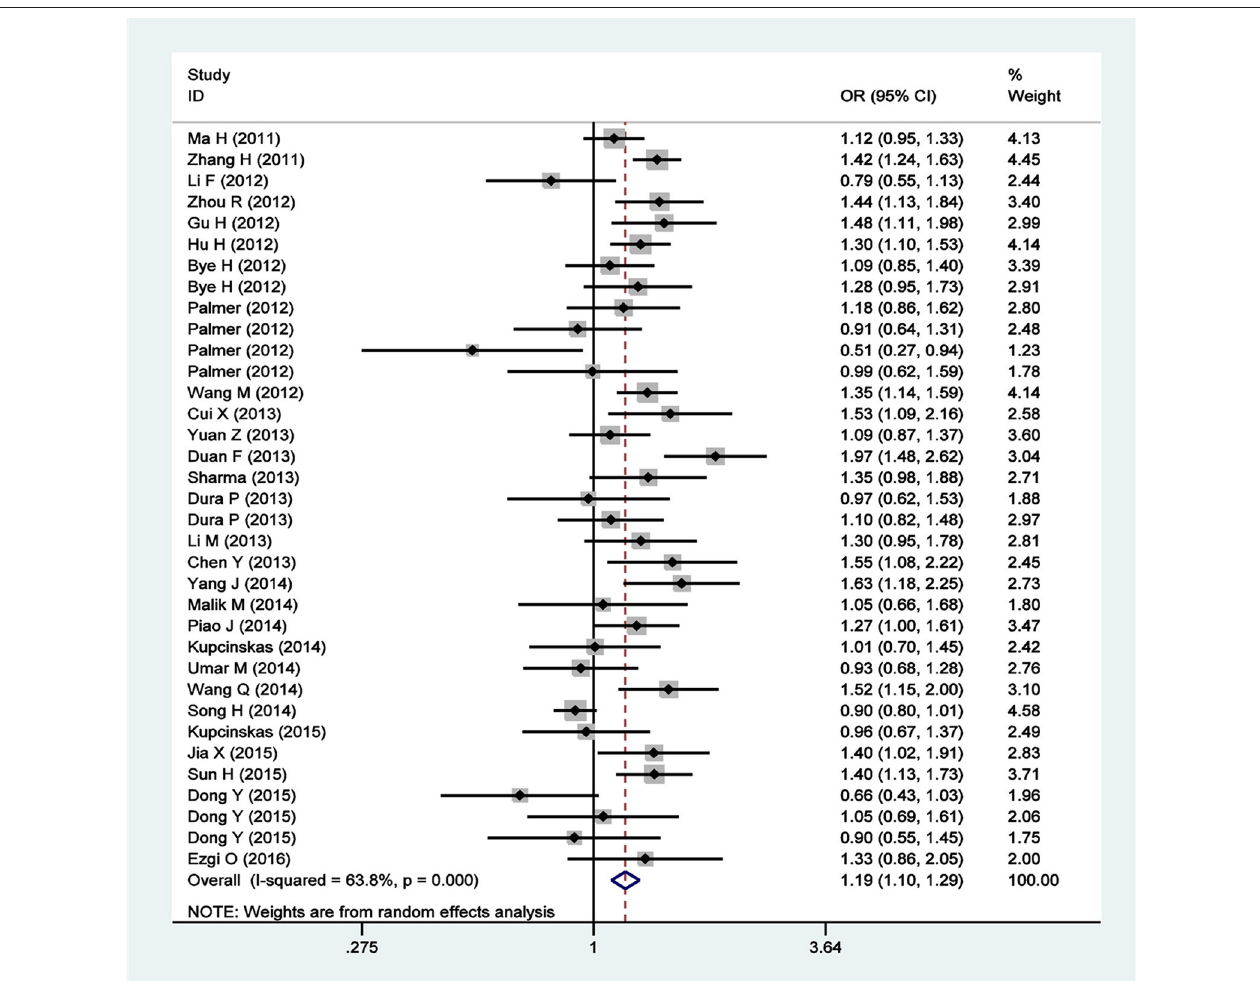
FIGURE 2 | Forest plots for rs2274223 polymorphism and cancer risk in dominant model (AG + GG vs. AA).